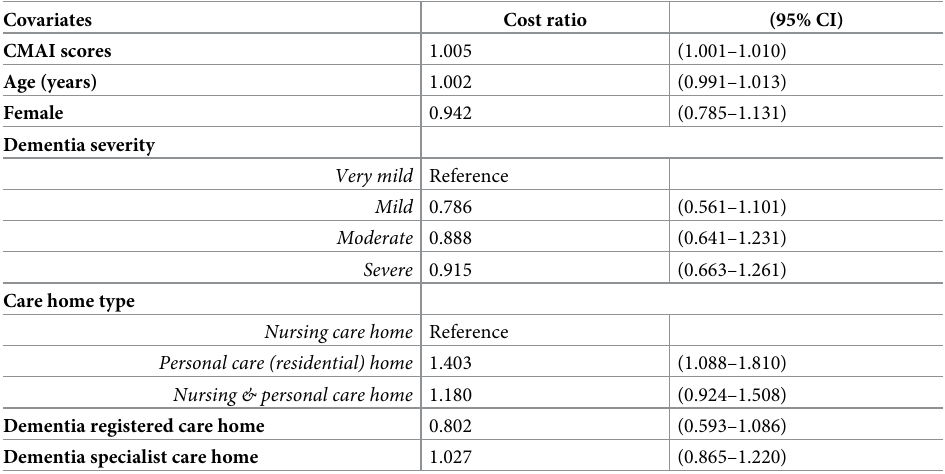
Table 3. Impact of agitation (by CMAI scores) and other factors on annual mean costs (£, 2014/15 UK), N = 1,396. Covariates